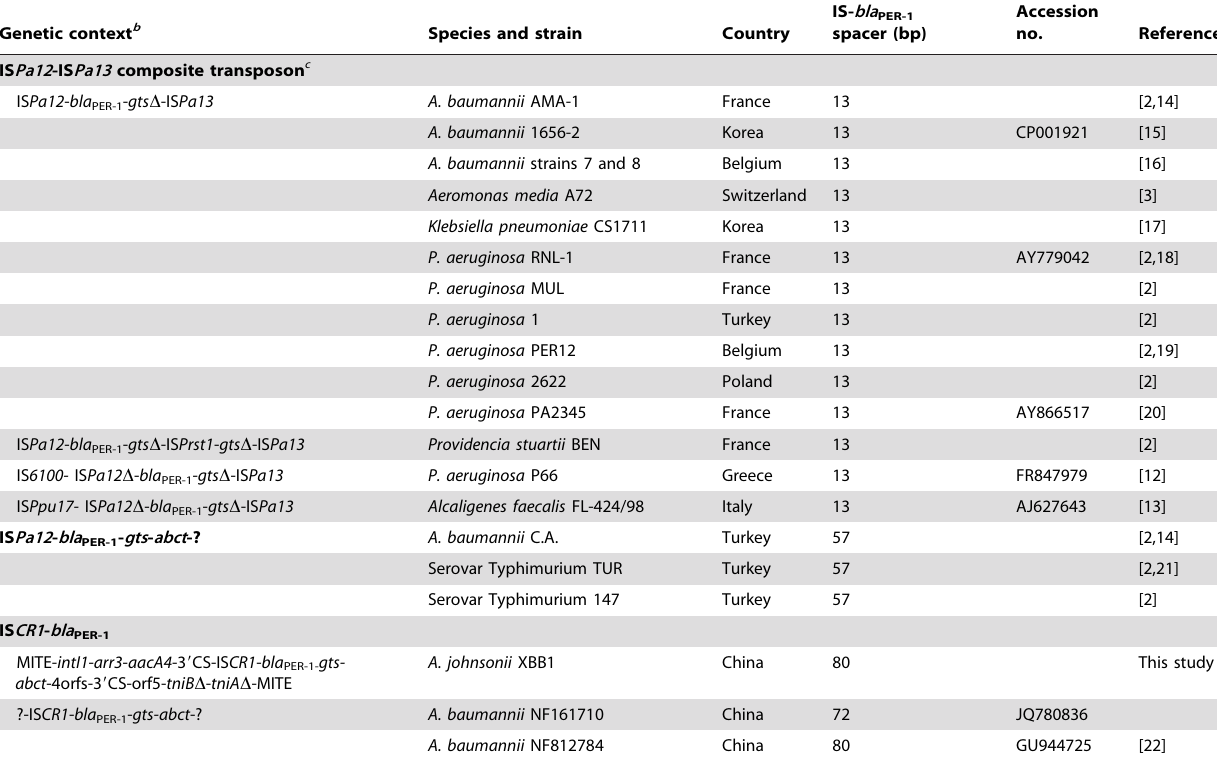
Table 1. Genetic contexts of bla PER-1